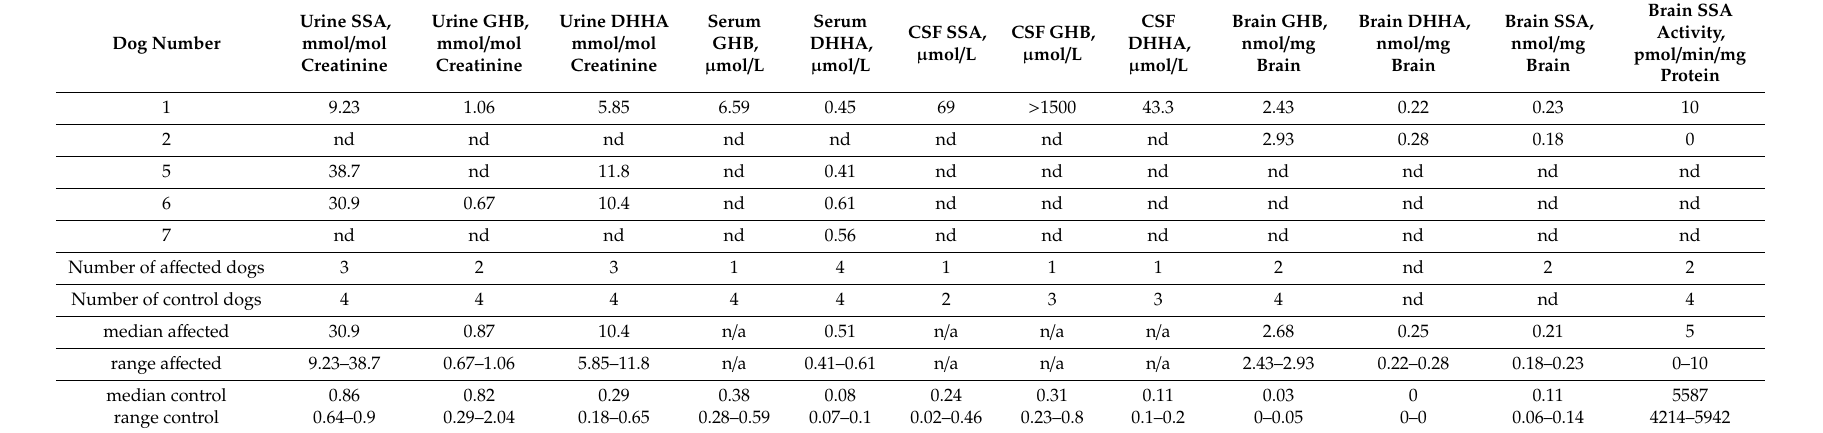
Table 2. Specific quantitative organic acids in urine, serum, CSF, and brain tissue in a ff ected and control dogs (nd = not